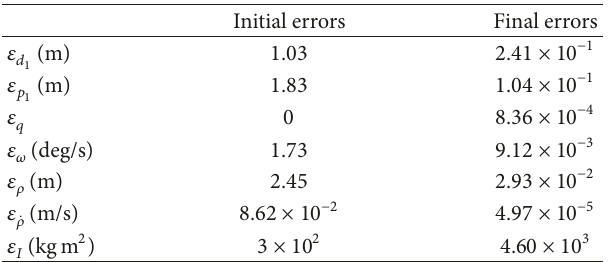
Table 2: Comparison between the norms of the errors at the beginning and at the end of the simulation. The 2-norm has been used for the inertia matrix error